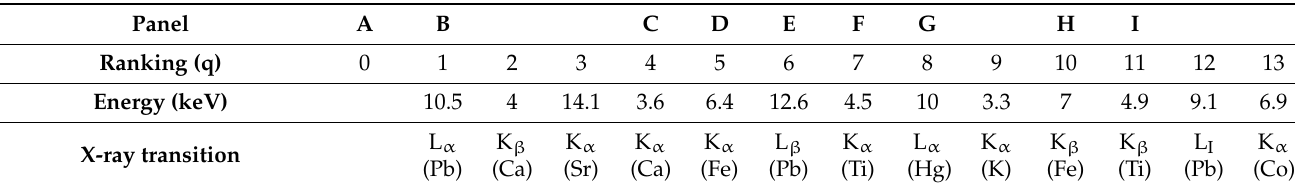
Table 5. The principal energies (elements’ emission series) emerging from the GS are evaluated from the isolated spectra. The series has been ordered following their abundance from the most to the less detected. The energy of the emission has been reported in keV and classified according to the X-ray nomenclature. The letters refer to Figure 6 and specify the series that has been removed before the calculation of the corresponding set of similarity